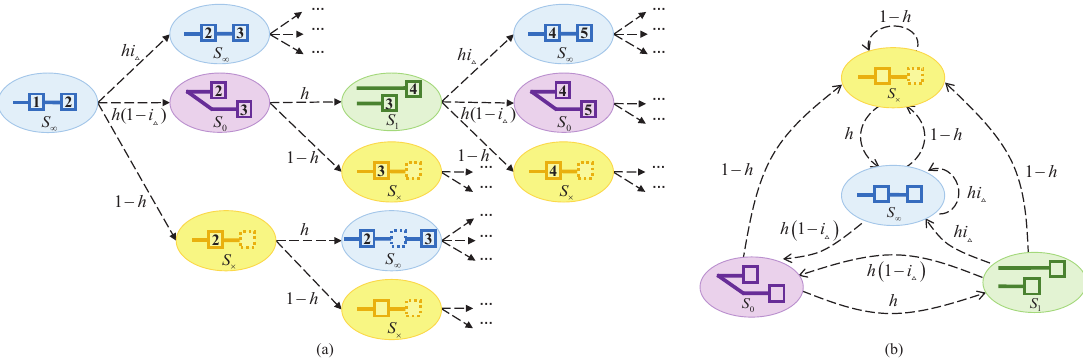
Figure 3. Blockchain evolution affected by information propagation delay. ( a ) The number of chain states skyrockets after three rounds. ( b ) Chain state space and transition